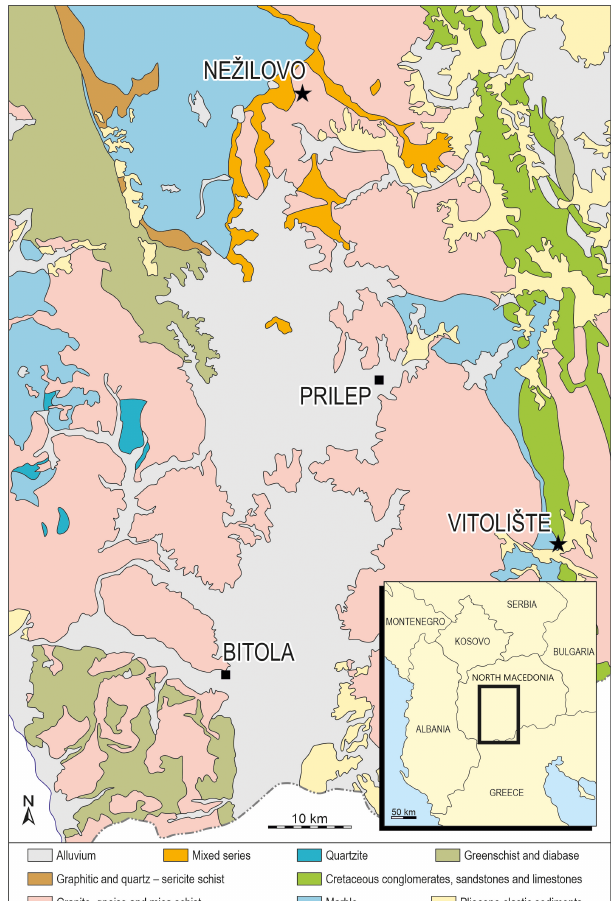
Figure 1. Geological map of the Republic of North Macedonia. The samples were found at 41.66118 ◦ N, 21.45426 ◦ E, and the locality has been marked by a black star named Nežilovo. The locality of ardennites found by Altherr et al. (2017) in Vitolište has also been marked. The map was created by the